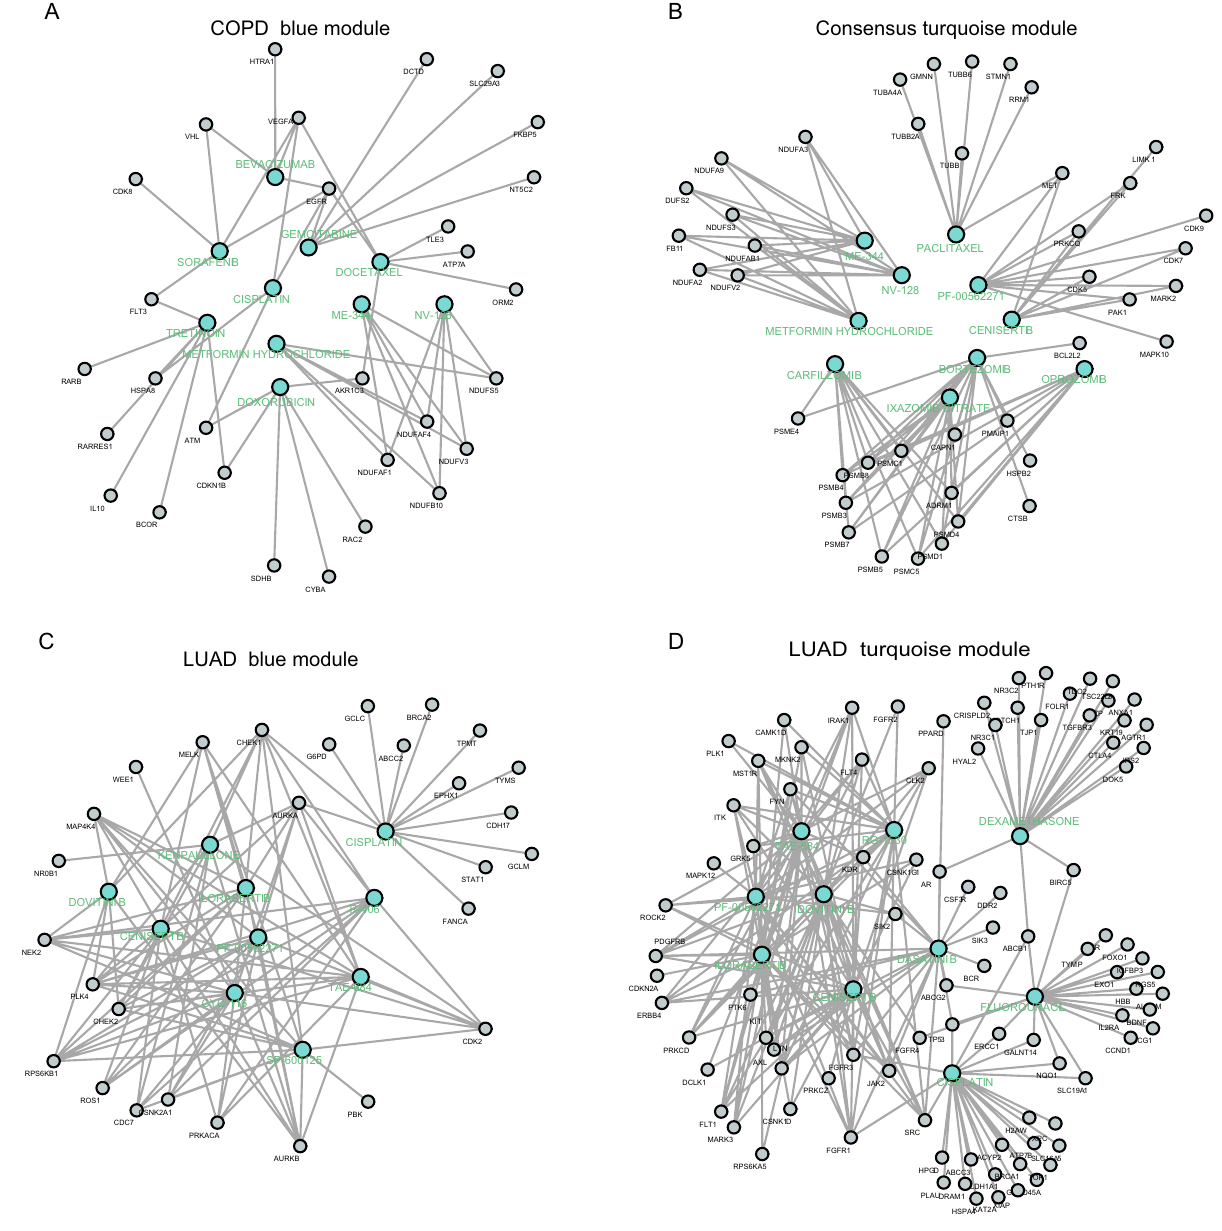
Figure 5. Candidate disease-specific drug-target networks. Label targets and drugs are colored black and turquoise, respectively. The size of the drug letters reveals the degree of the drug. ( A ), Candidate drug-target network of COPD blue module; ( B ), Candidate drug-target network of COPD-LUAD turquoise module; ( C ), Candidate drug-target network of LUAD blue module; ( D ), Candidate drug-target network of the LUAD turquoise module. COPD: chronic obstructive pulmonary disease; LUAD: lung